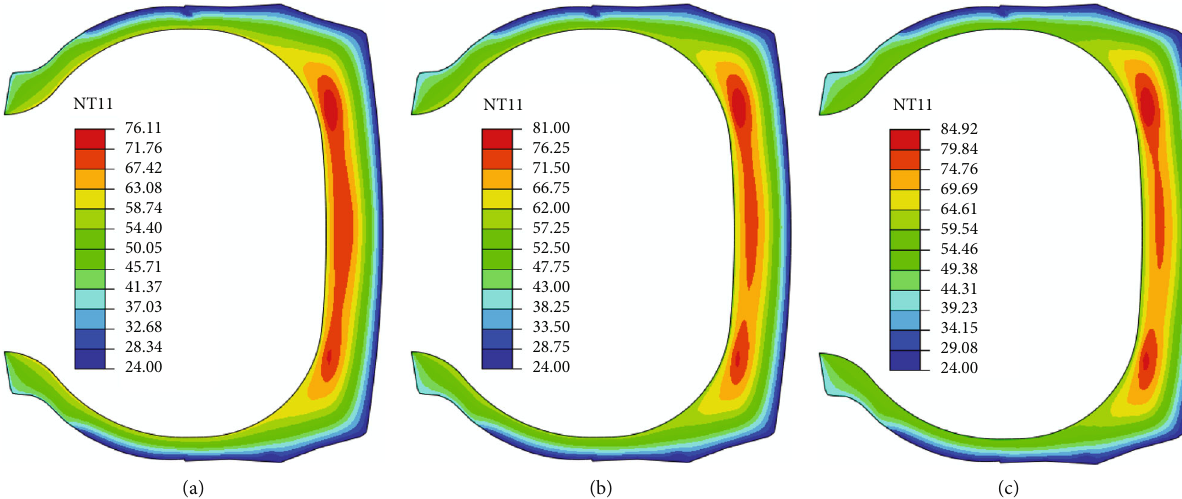
Figure 13: Temperature fi eld distributions of a tire at a speed of 7.5km/h: (a) 0.5MPa in fl ation pressure and 46667kg load (working Condition (1)), (b) 0.55MPa in fl ation pressure and 55000 kg load (working Condition (5)), and (c) 0.6MPa in fl ation pressure and 63333kg load (working condition (9)).